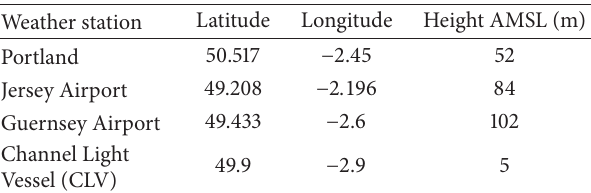
Table 2: Geographical coordinates of all the weather stations along with their